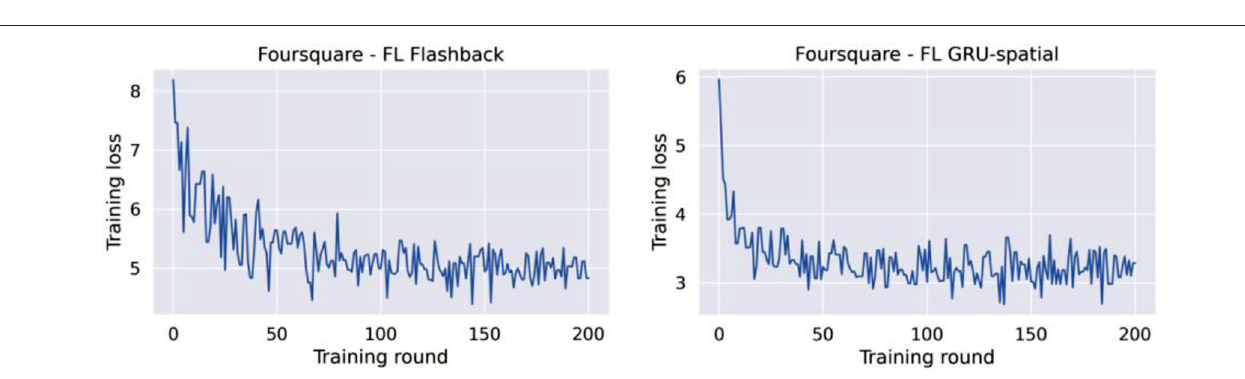
such a model is more prone to overfitting than a less complex